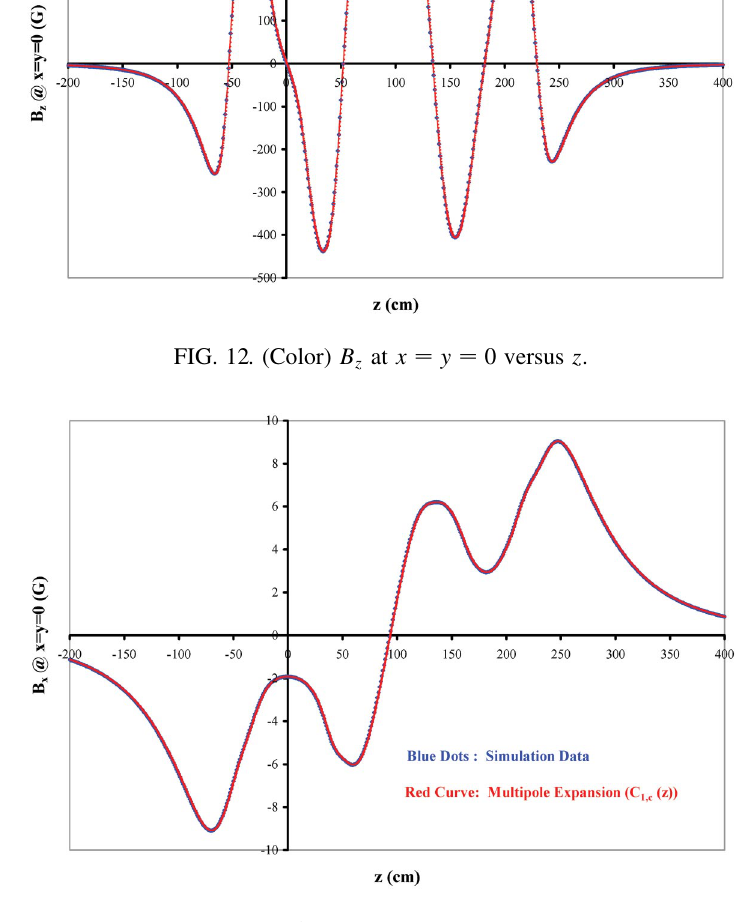
at x (cid:2) y (cid:2) 0 versus z x versus y at x (cid:2) z (cid:2) 0 y